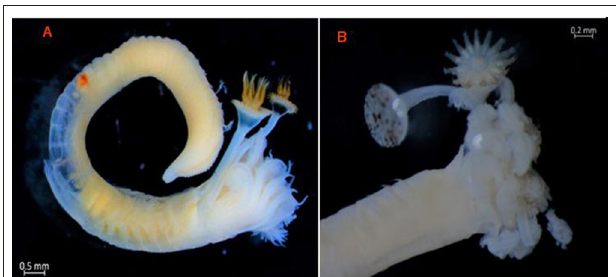
FIGURE 3 | (A) Bi-operculate Hydroides dianthus exhibiting two opercula with the same morphology on the gill crown. The verticil is composed of eight pointed spines that are completely smooth, the distal ends of which curve toward the ventral side of the operculum, so that the longer spines appear to curve toward the inside of the verticil and the shorter ventral spines appear to curve toward the outside. (B) Bi-operculate Hydroides elegans specimen exhibiting two opercula with different morphologies on the gill crown. The first operculum has a typical H. elegans morphology with two levels: the verticil develops first and then the basal funnel differentiates and expands to fit the hole in the tube. The second operculum presents the typical Serpula